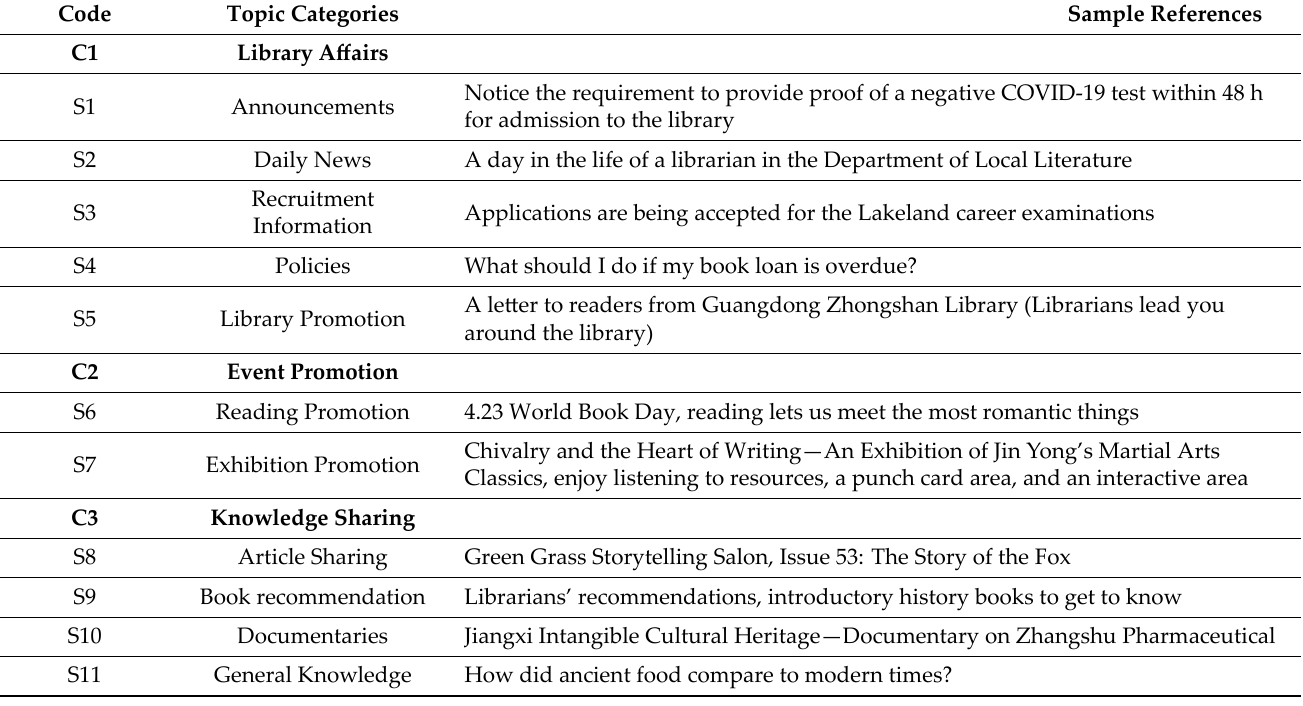
Table 4. Eighteen categories of video